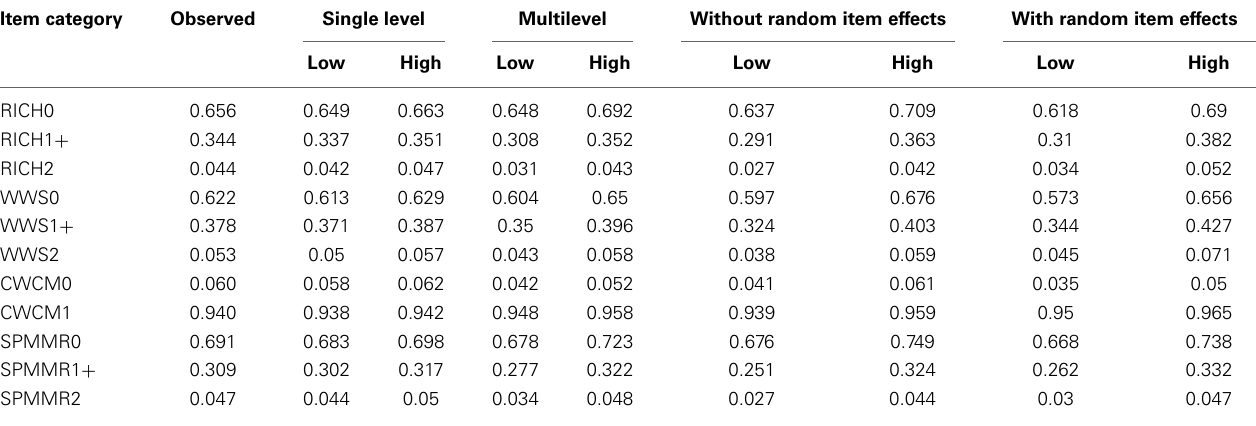
Table 3 | Posterior predictive checks for item fit (95% posterior